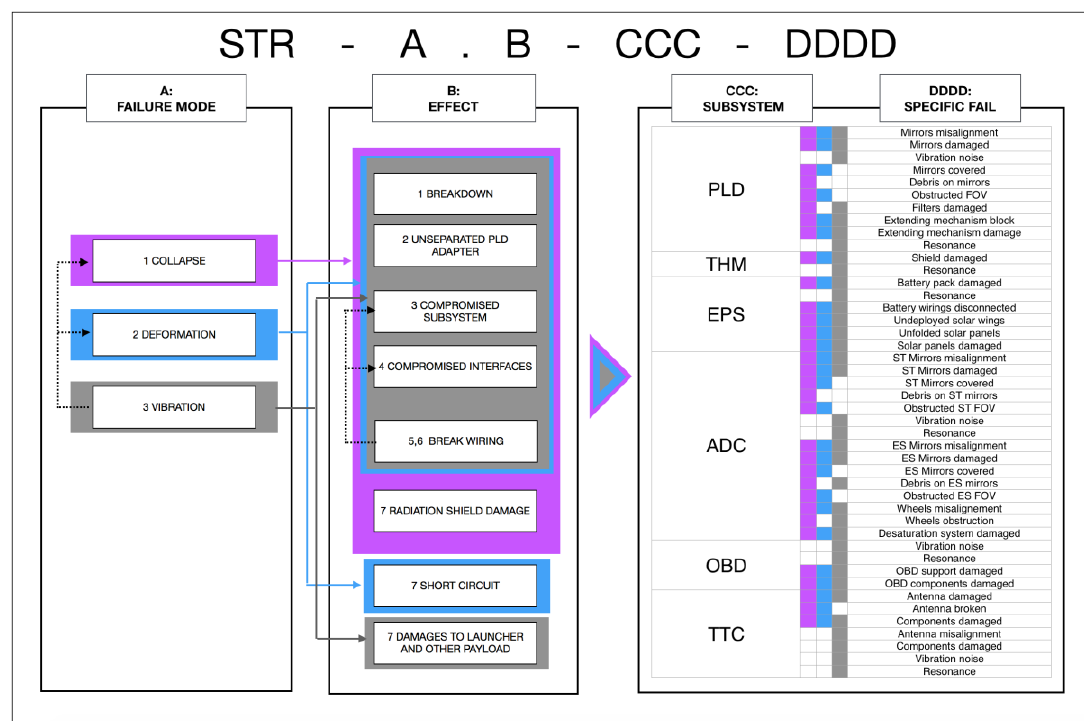
Figure 6. FMECA logical loop for STR.